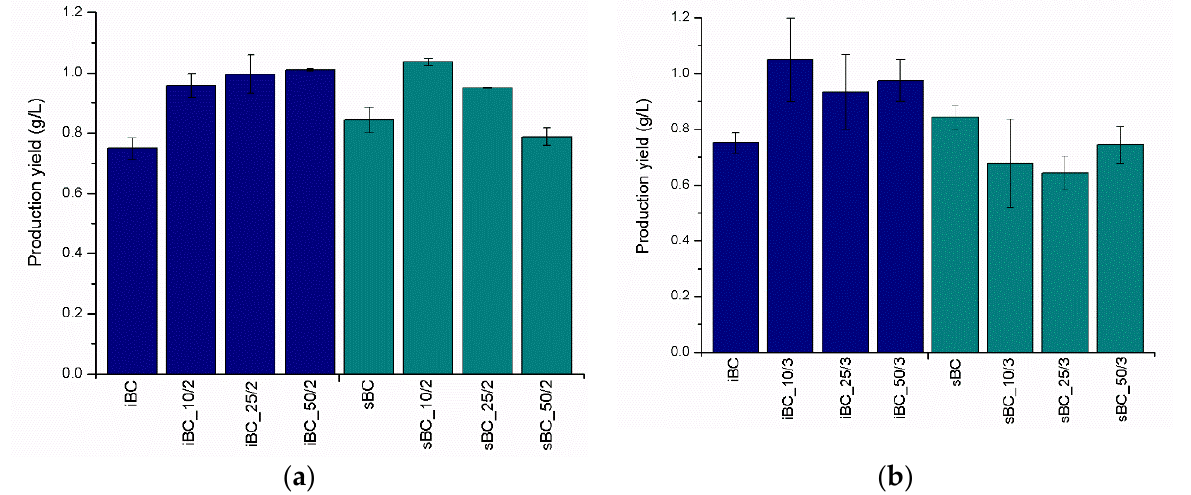
Figure 7. Production yield (g/L) of dry BC and GO/BC nanocomposites with ( a ) two and ( b ) three GO loading steps.